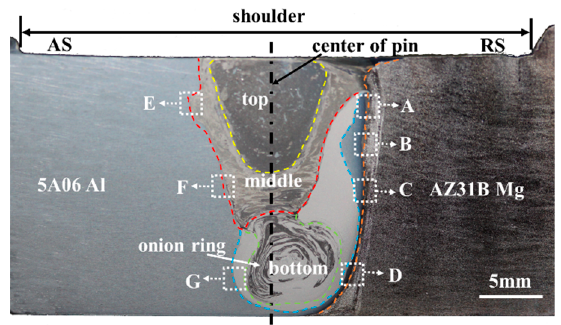
Figure 4. Low magnification overview of dissimilar FSW of Al/Mg alloy.